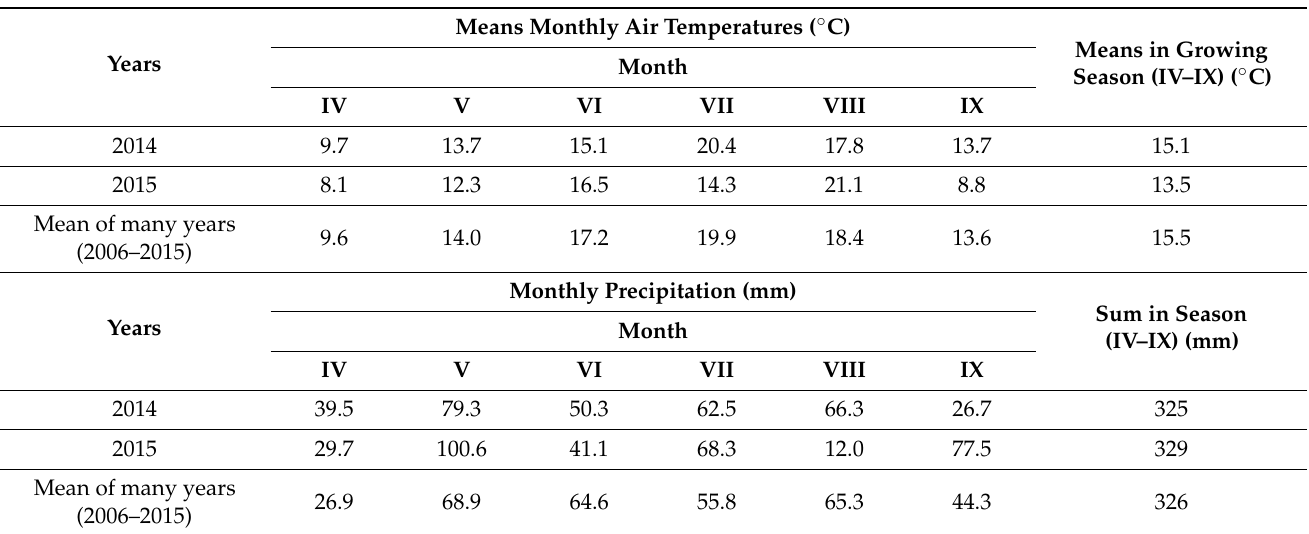
Table 1. Meteorological condition in years 2014–2015 by Meteorological station in